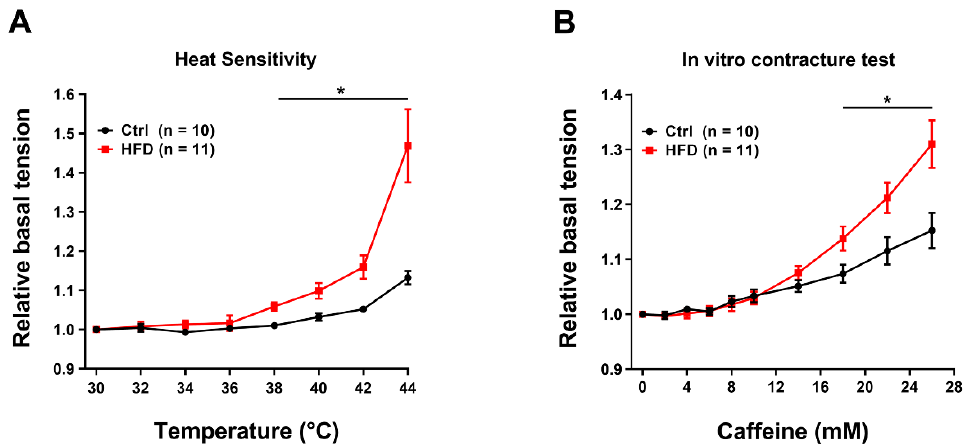
Figure 6. Temperature and caffeine dependence of basal tension in isolated EDL muscles. ( A ) Relative basal tension (normalized to 30 ◦ C) during exposure to increasing temperature (from 30 to 44 ◦ C). ( B ) Relative basal tension (normalized by 0 mM of caffeine) during exposure to increasing caffeine concentration (from 0 to 24 mM). Data are shown as mean ± SEM (* p < 0.05), as evaluated by two-way ANOVA followed by Tukey’s post-hoc test. n = number of EDL muscles tested.